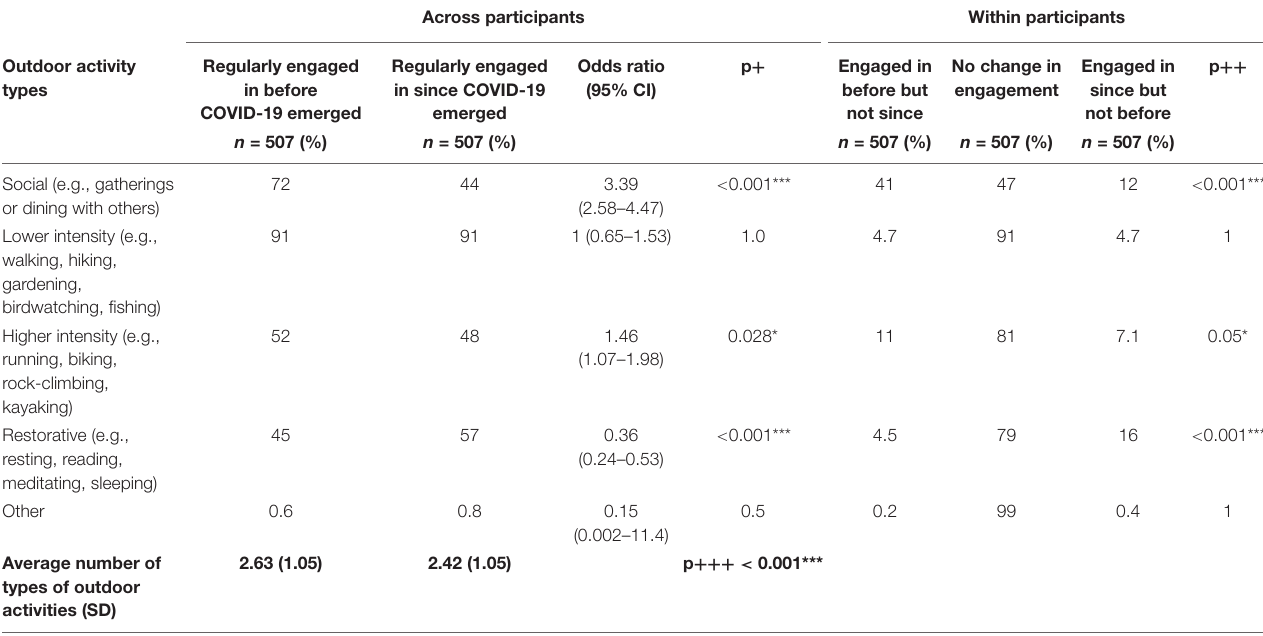
TABLE 3 | Changes in types of outdoor activities.